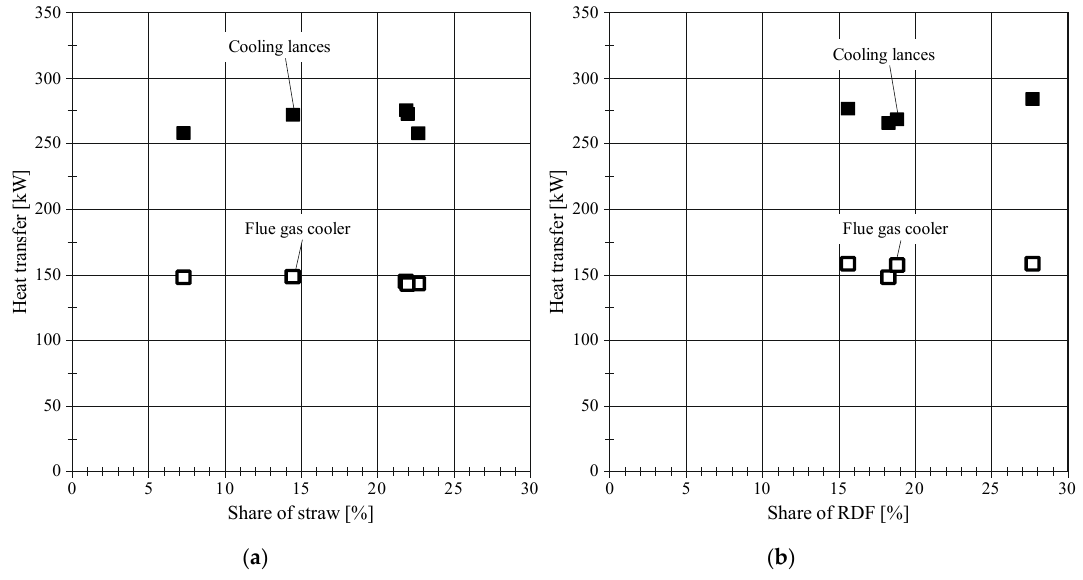
Figure 7. Heat transfer to cooling lances ( a ) and flue gas cooler ( b ) (similar share of co-fuel).